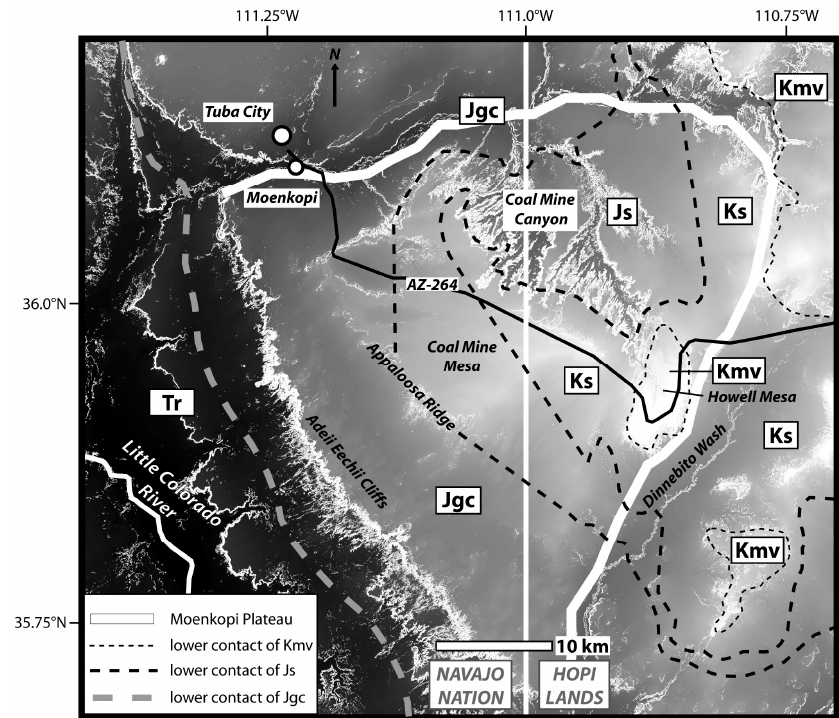
Figure 2. Digital elevation model (DEM) with geographic locations mentioned in the text. All slopes >10° are depicted by white pixels. Geologic contacts shown using dashed lines. Tr: undifferentiated Triassic rocks; Jgc: Jurassic Glen Canyon Group; Js: Jurassic San Rafael Group; Ks: Cretaceous Mancos shale; Kmv: Cretaceous Mesa Verde Group. Lowest elevations (~1200 m) in this figure occur along the Little Colorado River, highest elevations. (~2000 m) occur on Howell Mesa. The extent of the Moenkopi Plateau is bounded by the thick white line, the Adeii Eechii Clifffs comprise the southwestern border.